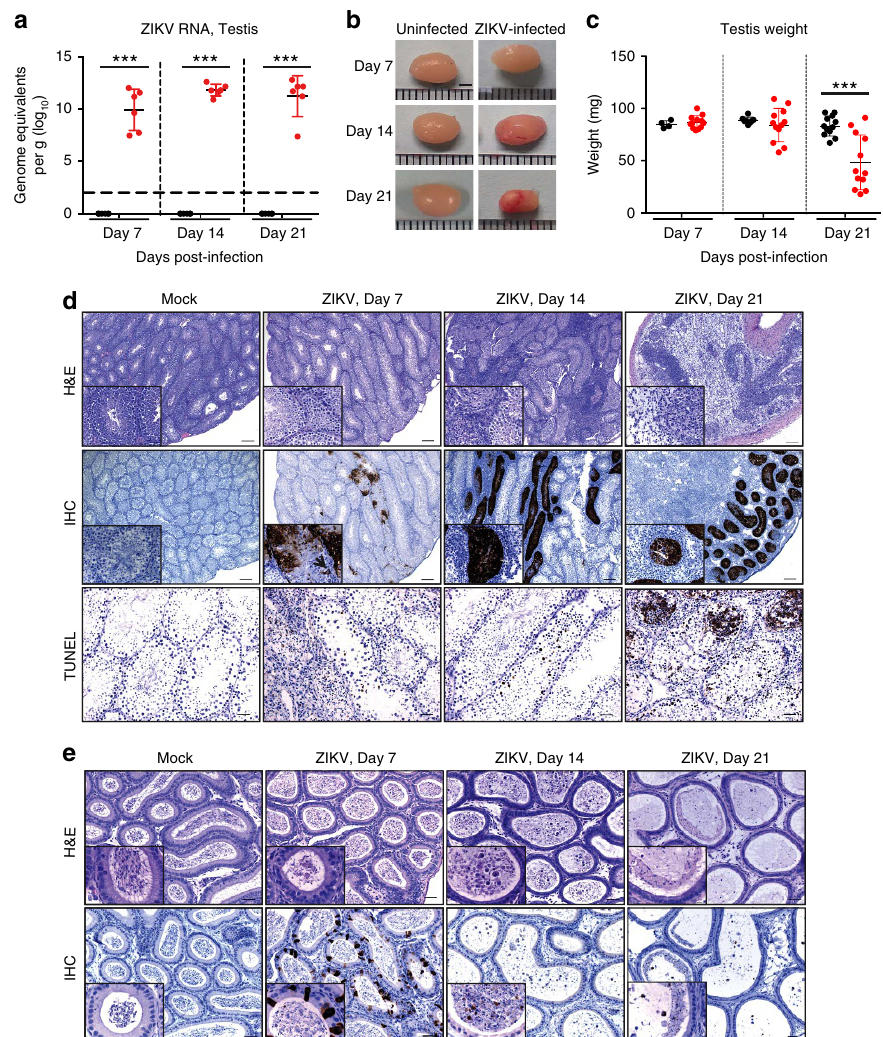
Figure 1 | ZIKV infection of the testis and epididymis. Ten- to eleven-week-old male Ifnar1 (cid:2) / (cid:2) mice were inoculated with 5 (cid:3) 10 5 p.f.u of ZIKV strain PRVABC59 by a subcutaneous route (s.c.) into each hind leg (1 (cid:3) 10 6 p.f.u. total) and compared to PBS mock-infected mice ( n ¼ 6). The testes and epididymides were collected at the indicated d.p.i. ( a ) ZIKV RNA copies in the testis of mice measured by quantitative reverse transcription (qRT)–PCR. Results are expressed as genome equivalents per gram of tissue. The horizontal hatched line indicates the limit of detection ( o 100 copies per ml). ( b ) Representative images of testis from mock-infected and ZIKV-infected mice at the indicated d.p.i. ( c ) Weight of the testis (two per mouse) from mock-infected and ZIKV-infected mice at the indicated d.p.i. ( d ) Histopathological analysis of the testis (upper panels), immunohistochemical labelling of ZIKV particles in the testis (middle panels), and TUNEL staining of testis (lower panels) at the indicated d.p.i. ( e ) Histopathological analysis of the epididymis (upper panels) and immunohistochemical labelling of ZIKV particles in the epididymis (lower panels) at the indicated d.p.i. Scale bars, 2mm in b 200, 200, 50 m m (top, middle and lower panels) in d and 50 m m in e . The data shown are from one experiment that is representative of the same outcome in the two studies performed. Bars indicate mean values and error bars indicate s.d. Statistical differences are given (two-way ANOVA followed by the Bonferroni post-test). *** P o 25 m g of the control vector (pVax1) or ZIKV-prME DNA vaccine (ZV-prME). Mice were challenged 2 weeks after the second immunization with a total of 1 (cid:3) 10 6 p.f.u. of ZIKV strain PRVABC59 by the s.c. route. The testes and epididymis were harvested at 28 d.p.i. from sham-vaccinated and vaccinated mice and compared to testes obtained from age-matched phosphate-buffered saline (PBS) mock-infected and ZIKV-infec- ted mice. Unvaccinated and sham-vaccinated mice that received a ZIKV challenge lost weight and 30% of the mice were euthanized due to weigh loss and other morbidity, including hind-limb paralysis (Supplementary Fig. 3a–c). Conversely, prME-vacci-